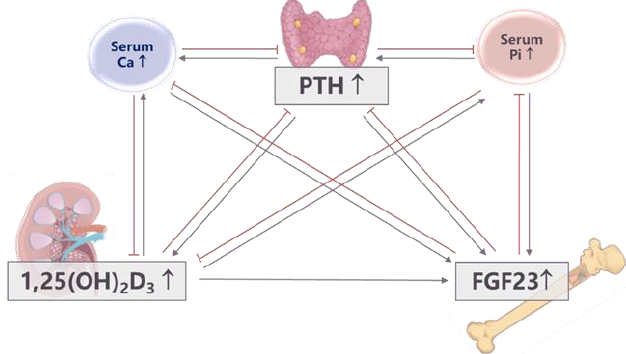
Figure 1. Phosphorus regulatory network. Note: Fibroblast growth factor 23 (FGF23), parathyroid hormone (PTH), and 1,25(OH)2D3 responds to the phosphorus load by modulating intestinal phos- phorus absorption, urinary phosphate excretion, and phosphate distribution into bone. In addition, these hormones are capable of modulating one another’s secretion in vitro and in vivo animal models, thus forming a complex phosphorus regulatory